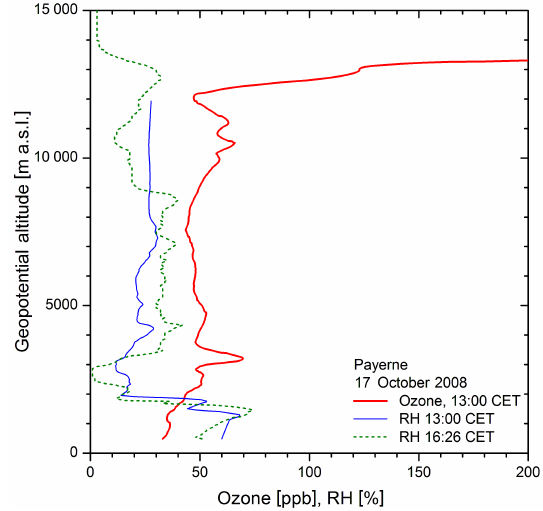
Figure 6. Comparison of the water-vapour mixing ratio from the CAELI Raman lidar (18:23CET, i.e. 15min average between 18:15 and 18:30) and the airborne lidar (18:15CET) at Bilthoven; the mix- ing ratios from the routine noon and midnight measurement at De Bilt (station code 6260) are given for comparison. The noon pro- file reveals a much more pronounced stage of the intrusion than the lidar data. In addition, the humidity result from a high-resolution ECMWF analysis for the time of the aircraft arrival is shown, again just indicating the intrusion layers (one of the two). The times for the lidar systems refer to the middle of a measurement, for the sonde the launch time (LT) was